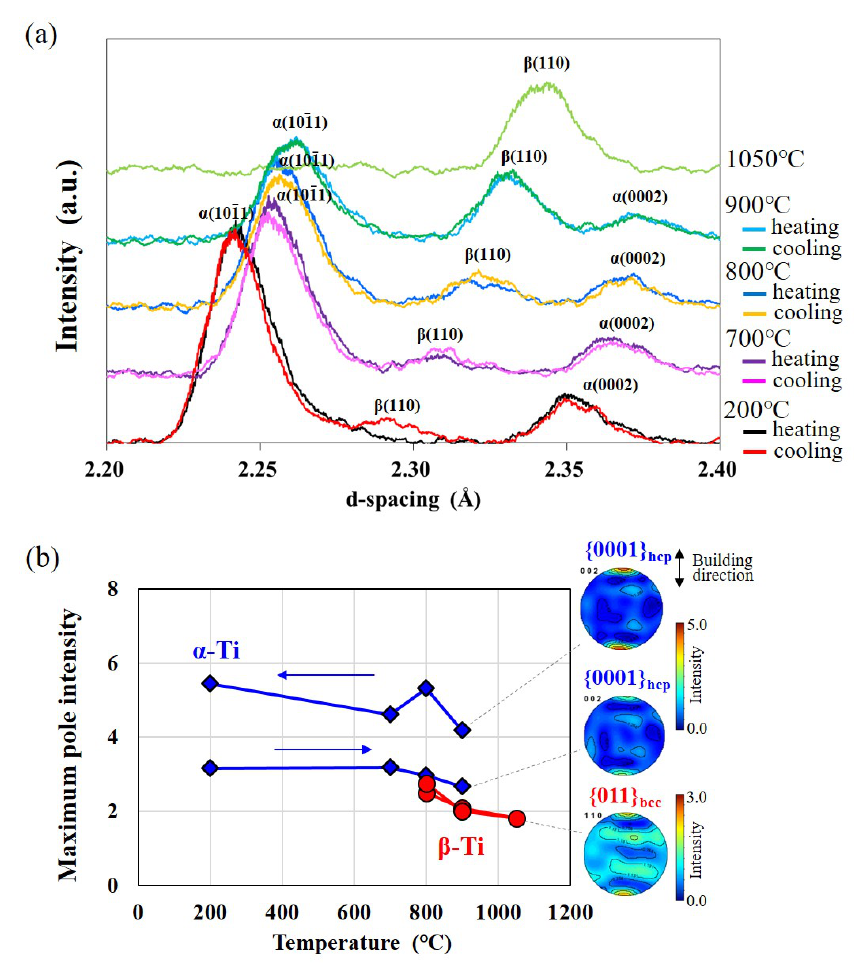
Figure 6. ( a ) Neutron time of flight diffraction spectra of Ti-6Al-4V measured at 200 ◦ C, 700 ◦ C, 800 ◦ C, 900 ◦ C and 1050 ◦ C. ( b ) Changes in the maximum pole density as a function of